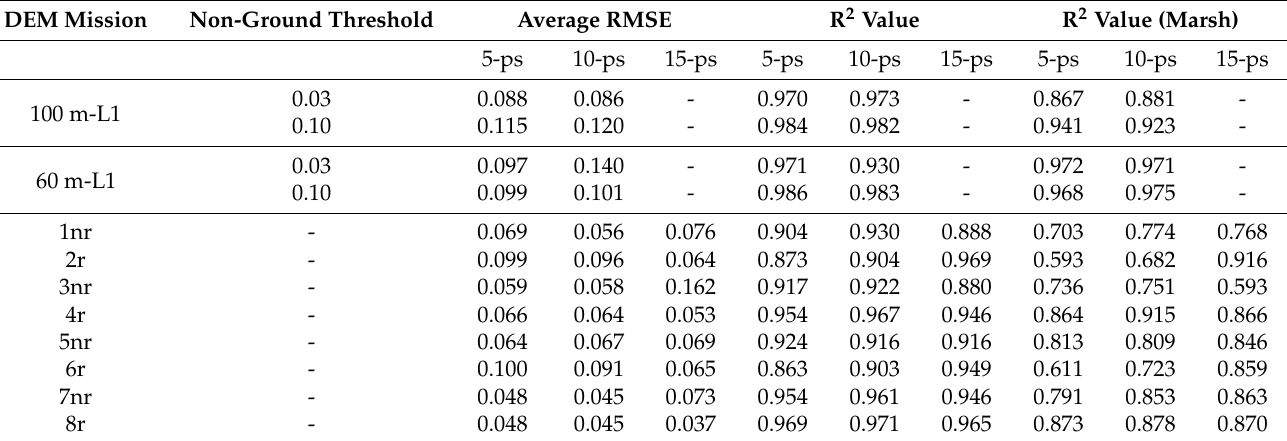
Table 7. LiDAR-derived DEM accuracy. nr: non-repetitive scan mode; r: repetitive scan mode; ps: point spacing.